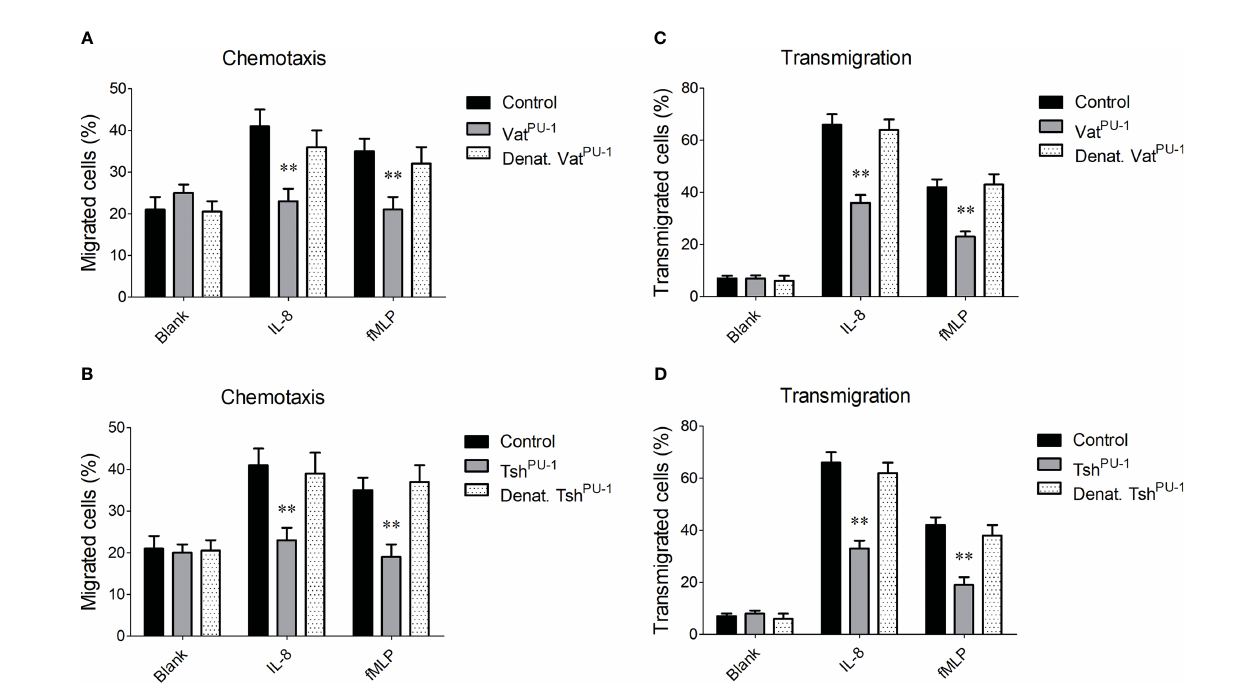
FIGURE 5 The impairment mediated by Vat PU-1 and Tsh PU-1 to the PMNs ’ chemotaxis and transmigration through endothelial cell monolayers. (A, B) Assessment of PMNs ’ chemotaxis. The calcein- labeled PMNs were treated with indicated proteins, or PBS vehicle control in the upper chamber of Transwell; IL-8 or fMLP were added to the lower chamber. Penetration of cells through the membrane was measured after 4 h fl uorometrically. (C, D) Assessment of PMNs ’ transmigration. The preincubated PMNs were applied to the upper chamber of Transwell supporting HBMEC, and transmigrated PMNs were enumerated as mentioned before. Statistical signi fi cance was determined by a one-way ANOVA test based on comparisons with the control group (** P <0.01). Error bars represent the SDs for three independent